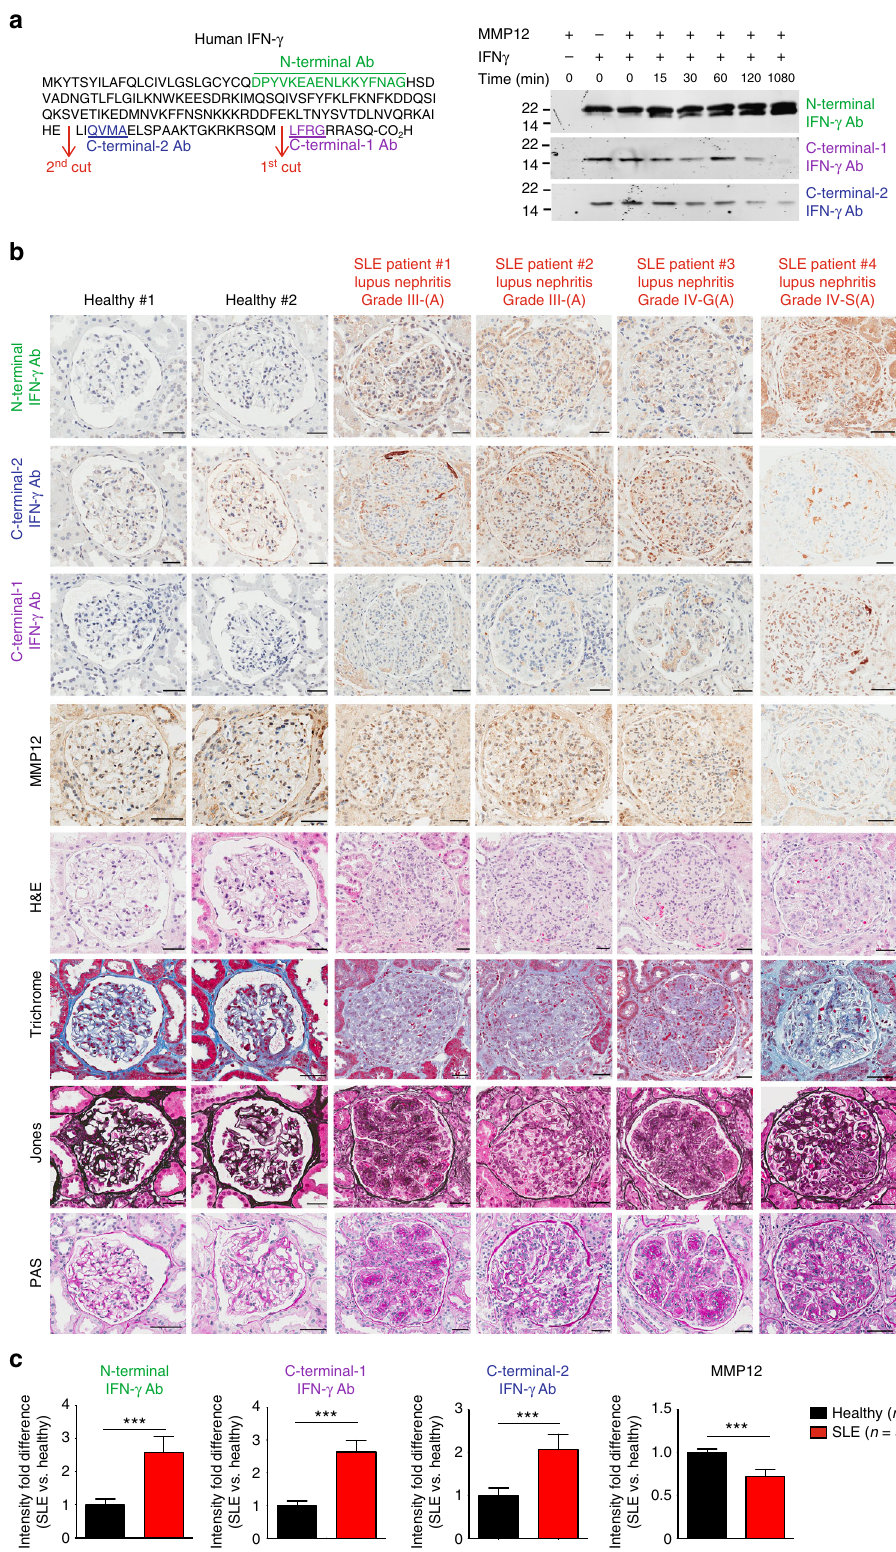
can be synchronized between mice upon injection of CFA for severe arthritic and kidney disease development 41 before gross lymphadenopathy reached humane end points as determined by the UBC Animal Care Committee. To analyze collagen-induced arthritis, we backcrossed Mmp12 – / – mice on the 129Sv/Ev background for seven generations onto the B10.RIII-H2 r H2-T18 b background (The Jackson Laboratory, stock #000457 23 ). Genotyping